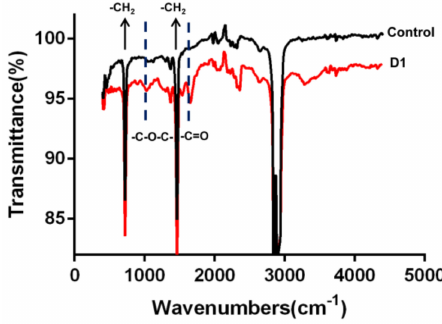
Figure 4. Distribution of carbonyl bands (-C = O, 1652 cm − 1 ) and ether groups (-C-O-C-, 1075 cm − 1 ), observed with a FTIR microscope on the PE film treated with D1 for 31